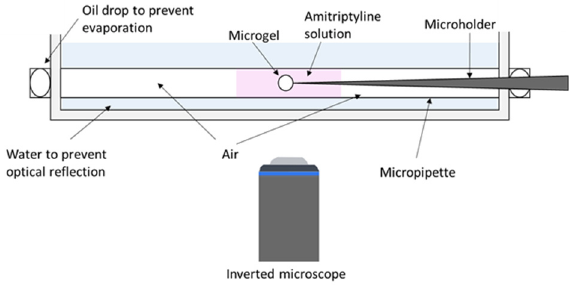
Figure 1. Schematic illustration of the limited-volume experiment set-up. A single microgel is positioned inside AMT solution by a micropipette. The microtube is sealed to prevent evaporation. The volume ratio vs. binding ratio is shown in Figure 2 and microscopy images of microgels from selected points on the curve are shown in Figure